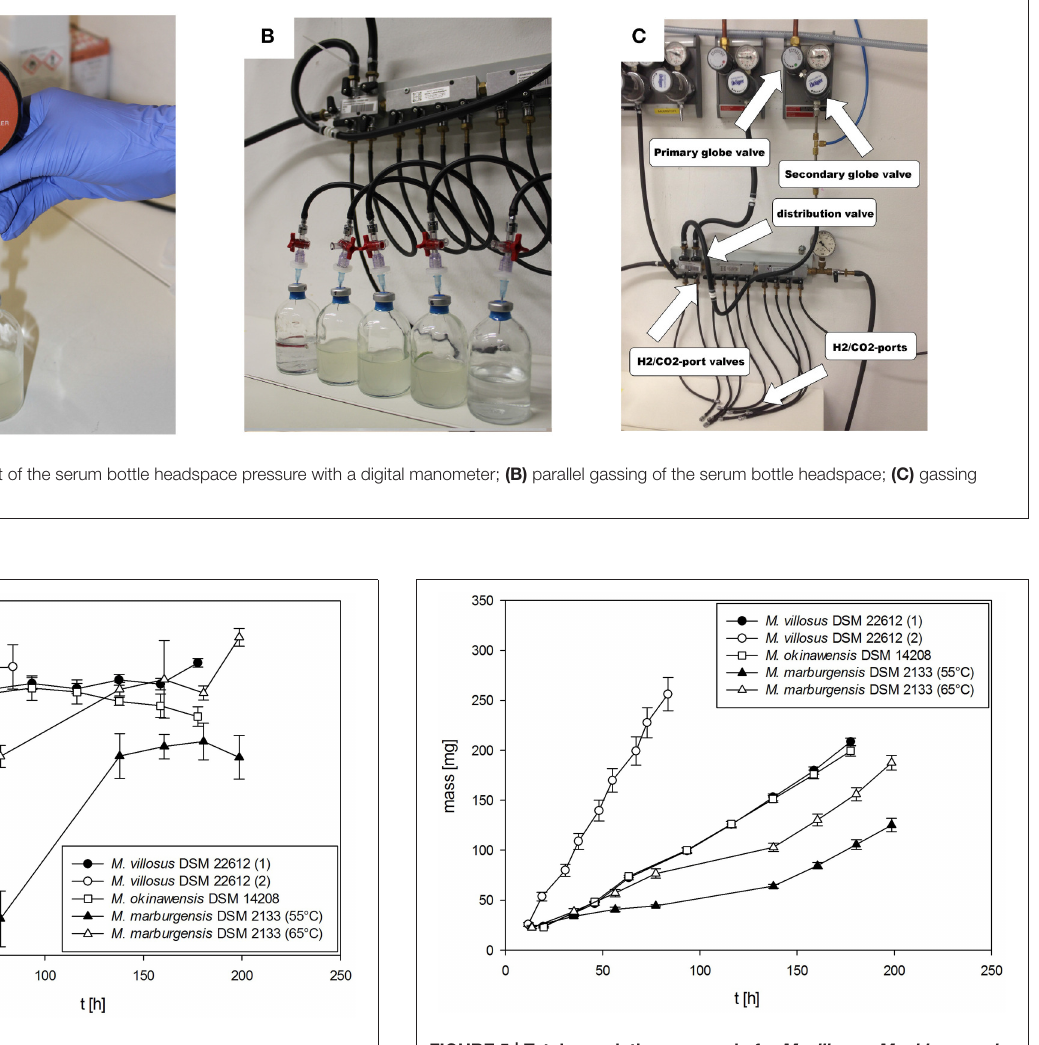
FIGURE 4 | Mass gain for M. villosus , M. okinawensis and M. marburgensis . For M. villosus an experiment with a daily gassing event [marked M. villosus (1)] and one experiment with two gassing events per day [marked as M. villosus (2)] were performed. For M. marburgensis cultivations at 55 ◦ C and at 65 ◦ C were performed. Negative controls are not shown.